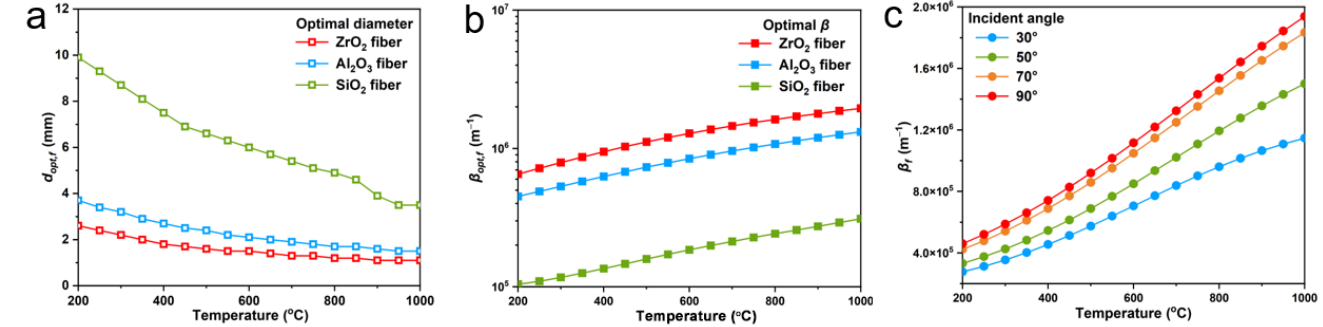
Figure 1. The radiative properties of three fibers. ( a ) Optimal cylinder diameter of various fibers. ( b ) Optimal temperature-dependent extinction coefficient of fibers based on the optimal diameter. ( c ) Temperature-dependent extinction coefficient of ZrO 2 fibers against angle between fiber axis and incident radiation.